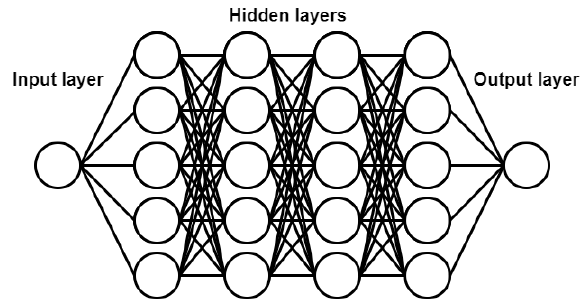
Figure 4: Simplified representation of the feed-forward neural network used.